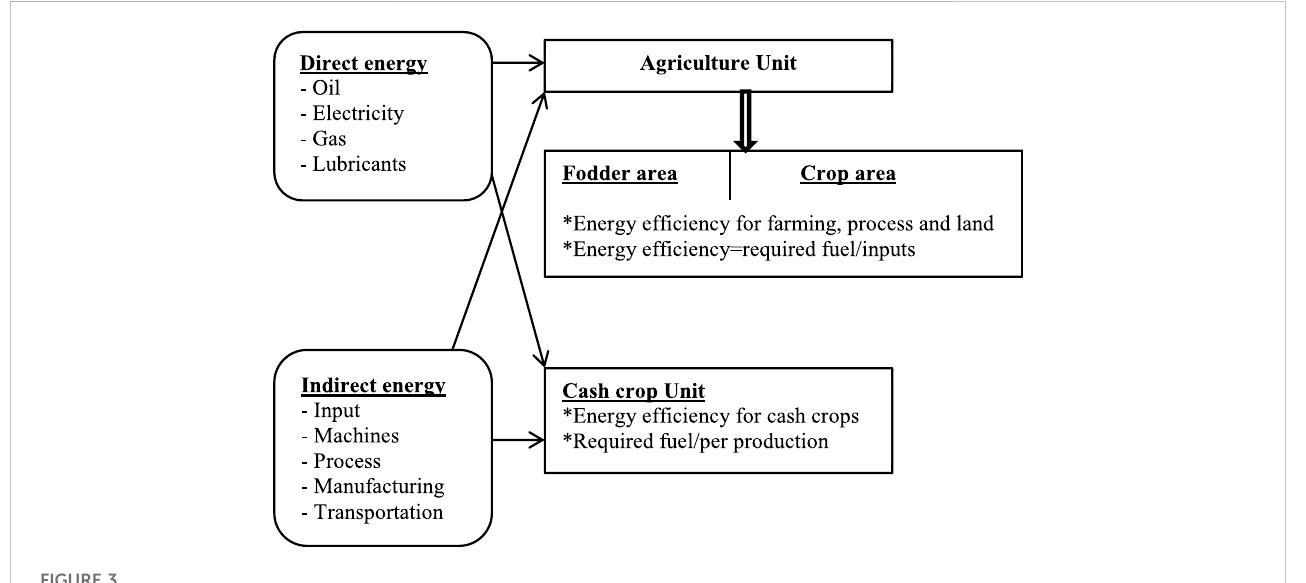
FIGURE 3 Framework based on agricultural energies and output